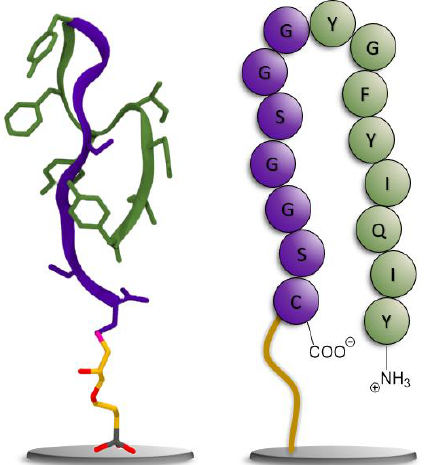
Figure 4. Left : Representative structure of the equilibrium-folded structure of the peptide; the glycine–serine linker is shown in purple, and the peptide aptamer in green, with the silane linker shown in licorice representation. Right : Cartoon representation of the peptide for comparison using the same color scheme.